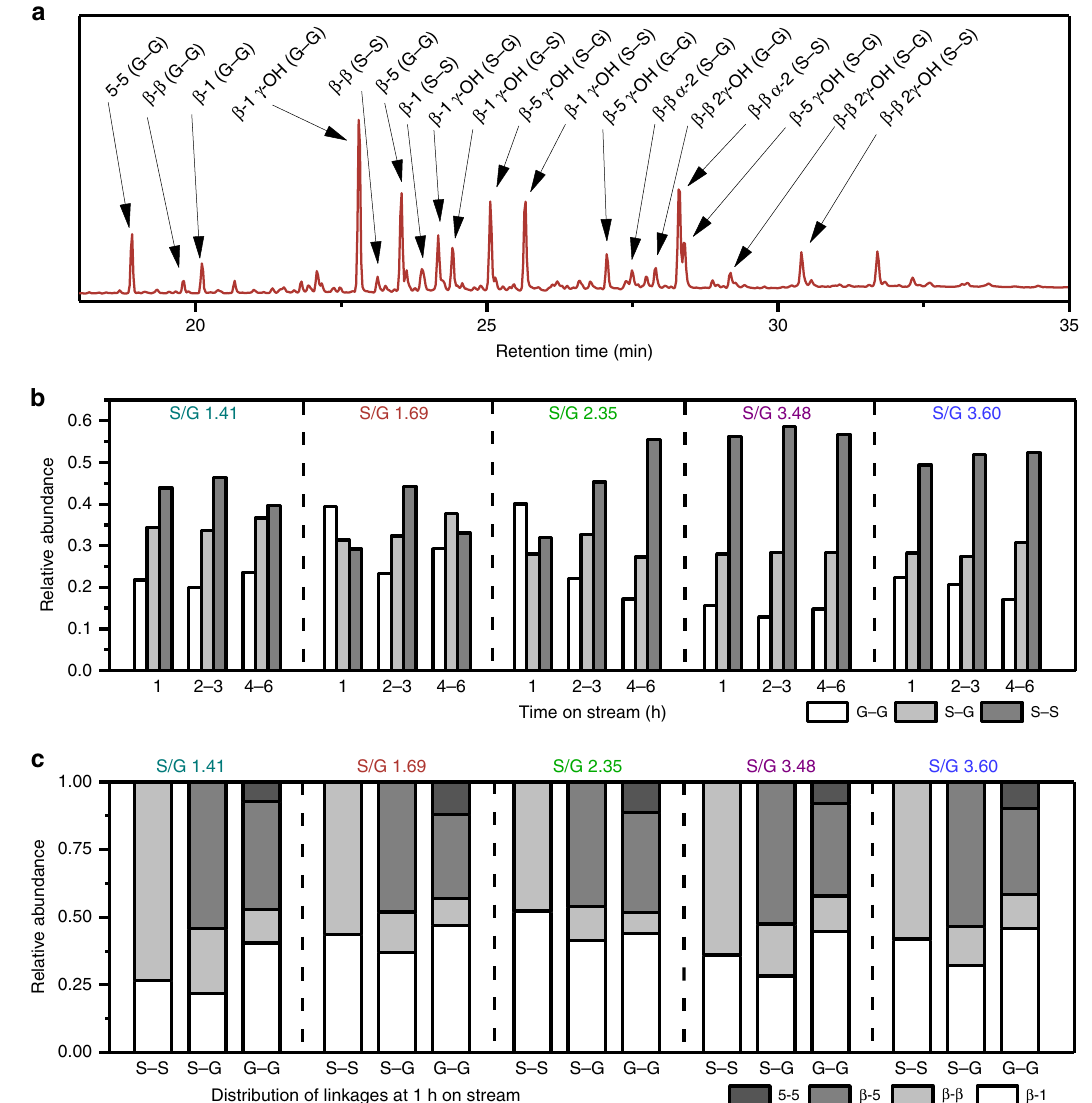
Fig. 5 Distribution of C – C linked dimers observed from fl ow-through RCF reactions. a Chromatogram from a representative GC-MS run with a silylated lignin oil (speci fi cally, S/G = 1.69 at 1 h on stream). The intensity of the peaks measured in total ion counts. b The relative occurrence of the different coupling partners at different times on stream as determined by relative GC-MS total ion count peak areas. c The relative distribution of linkage types with in each monomers coupling pair as determined by relative GC-MS total ion count peak areas. Note that all dimer analysis was done on the same samples as those shown in Figs. 2 and